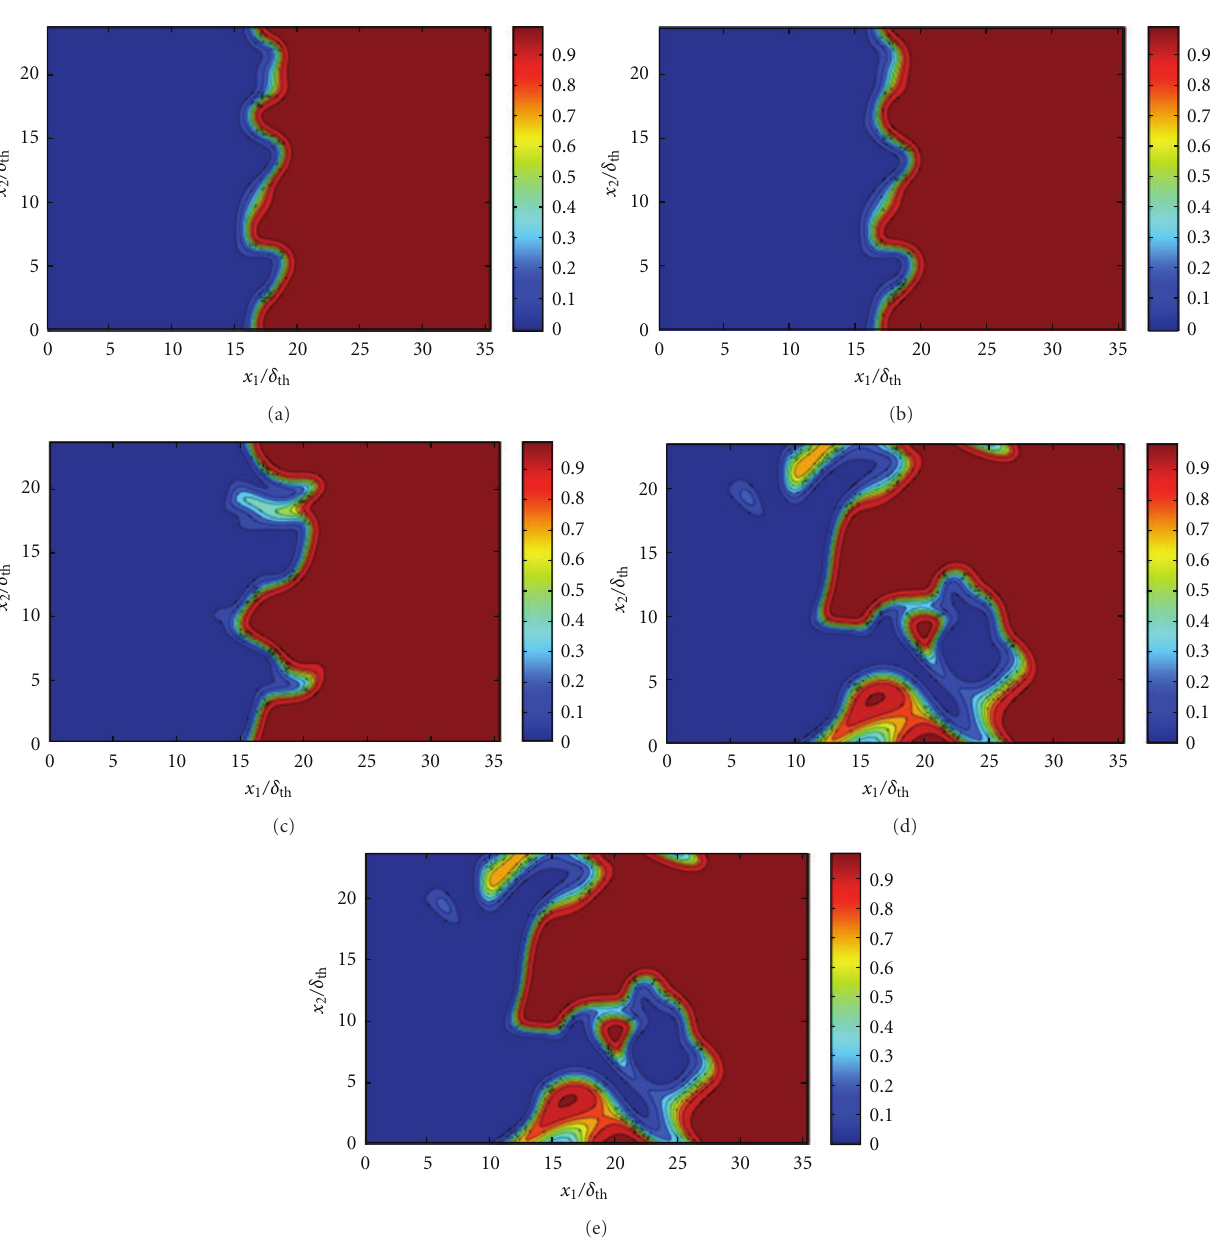
Figure 1: Contours of c in the x 1 - x 2 midplane at time t = δ th /S L for: (a–e) cases